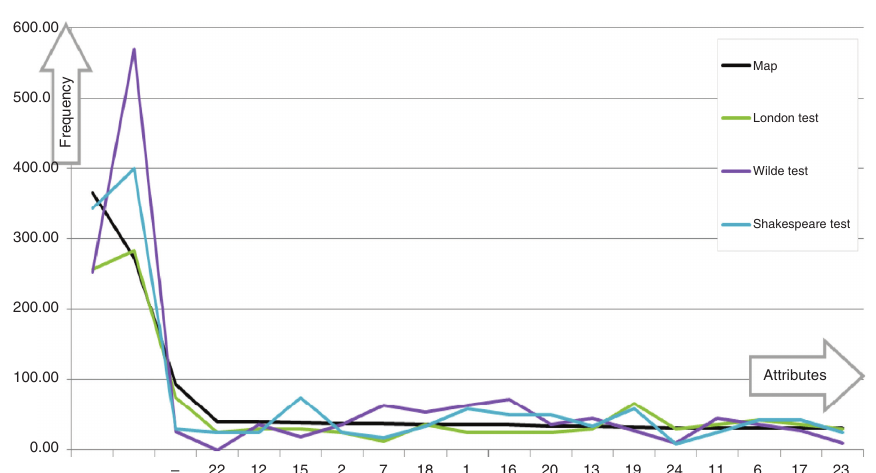
Figure 4: London’s Map vs. Authors’ Test